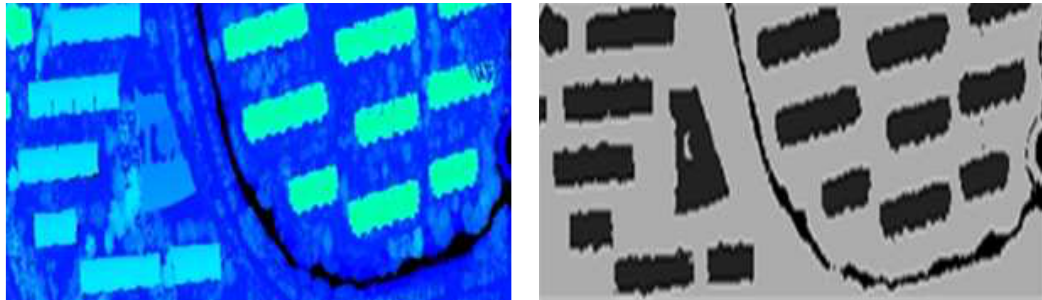
Figure 7. HDR 2 elevation coloration and manual extraction